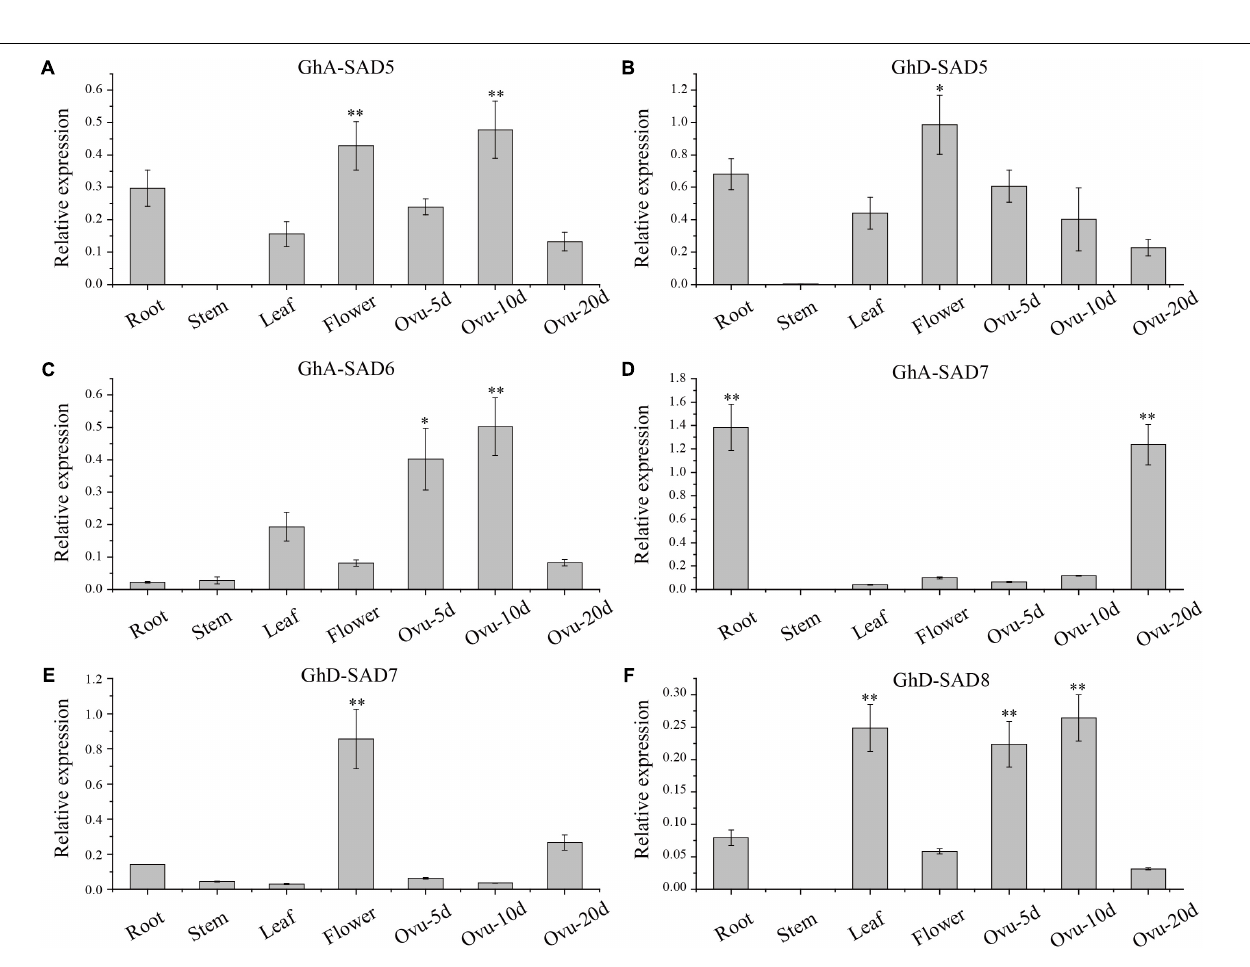
contributors for biosynthesis and accumulation of palmitoleic acid in cotton